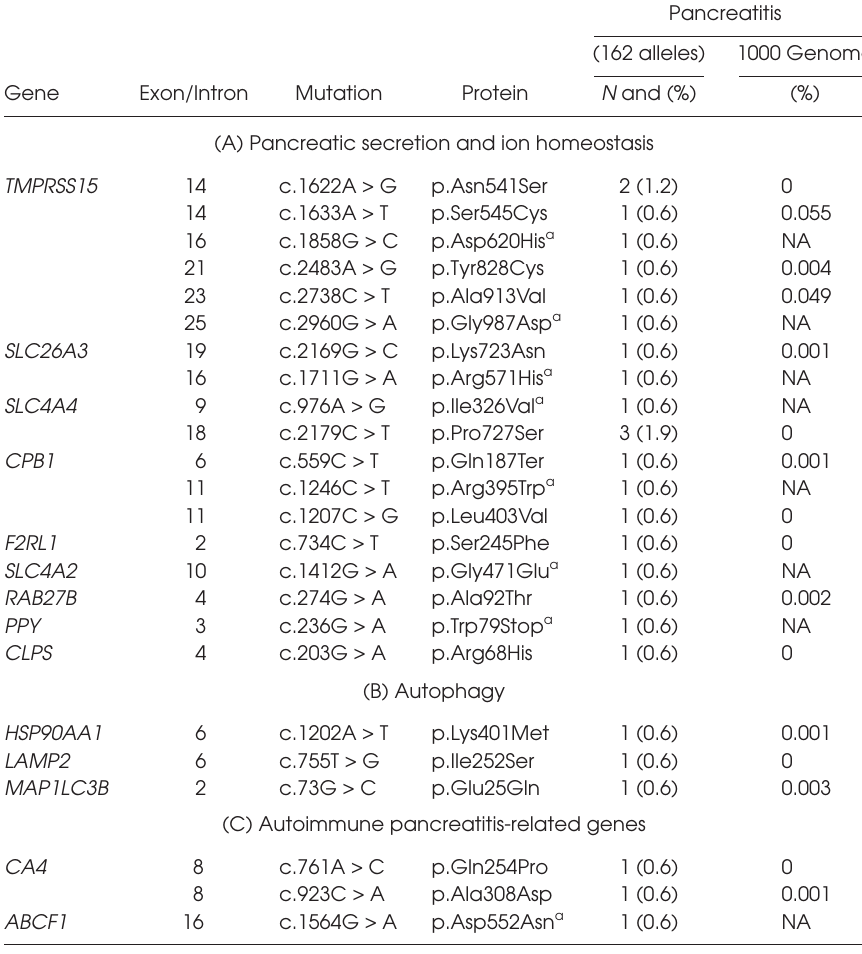
Table 3. Mutation frequency in genes encoding proteins involved in (A) pancreatic secretion and ion homeostasis, (B) autophagy and (C) autoimmune pancreatitis-related genes.